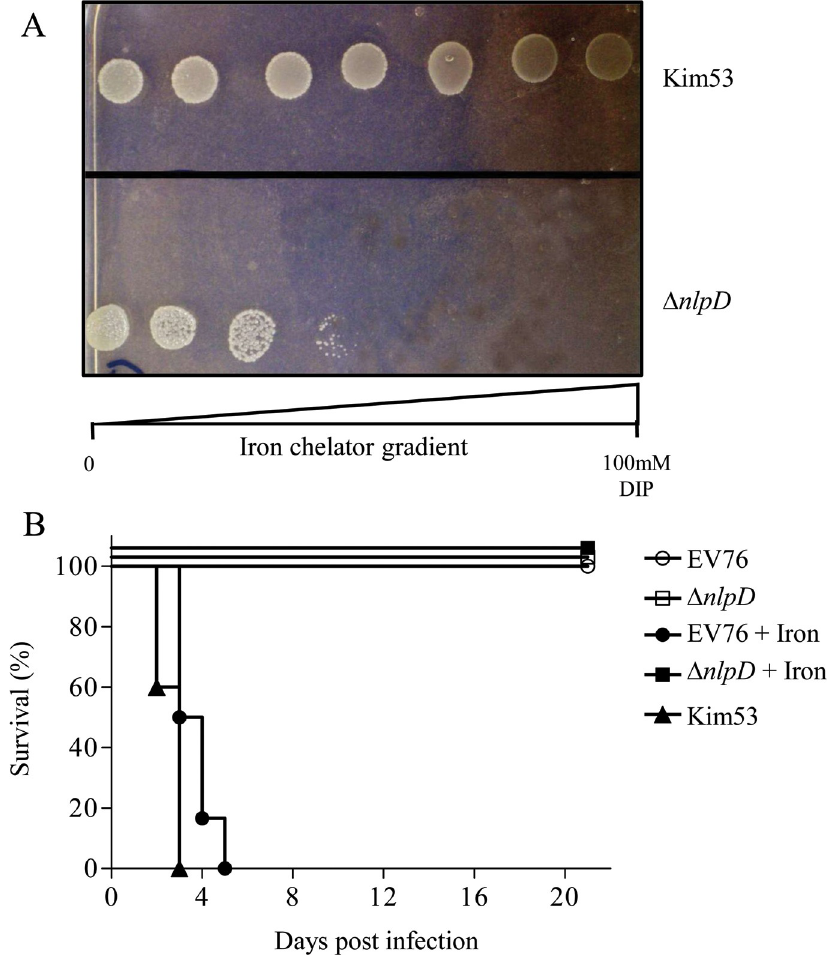
Fig 1. Role of iron in nlpD mutant growth and pathogenesis. A. Growth of Y . pestis strains under iron-limiting conditions. Kim53 (upper panel), Kim53 Δ nlpD (lower panel). The displayed data is one representative experiment. B. Survival curves of iron-treated mice infected with attenuated Y . pestis strains. Two groups of 12 mice were infected with the attenuated Y . pestis EV76 (circles) or Kim53 Δ nlpD (square) strains (s.c. infection with 10 7 cfu/mouse). In each group, six mice were treated with iron dextran (filled symbols), and six mice served as control (open symbols). Survival curve of mice infected with the Y . pestis Kim53 strain (s.c. infection with 10 6 cfu/mouse,